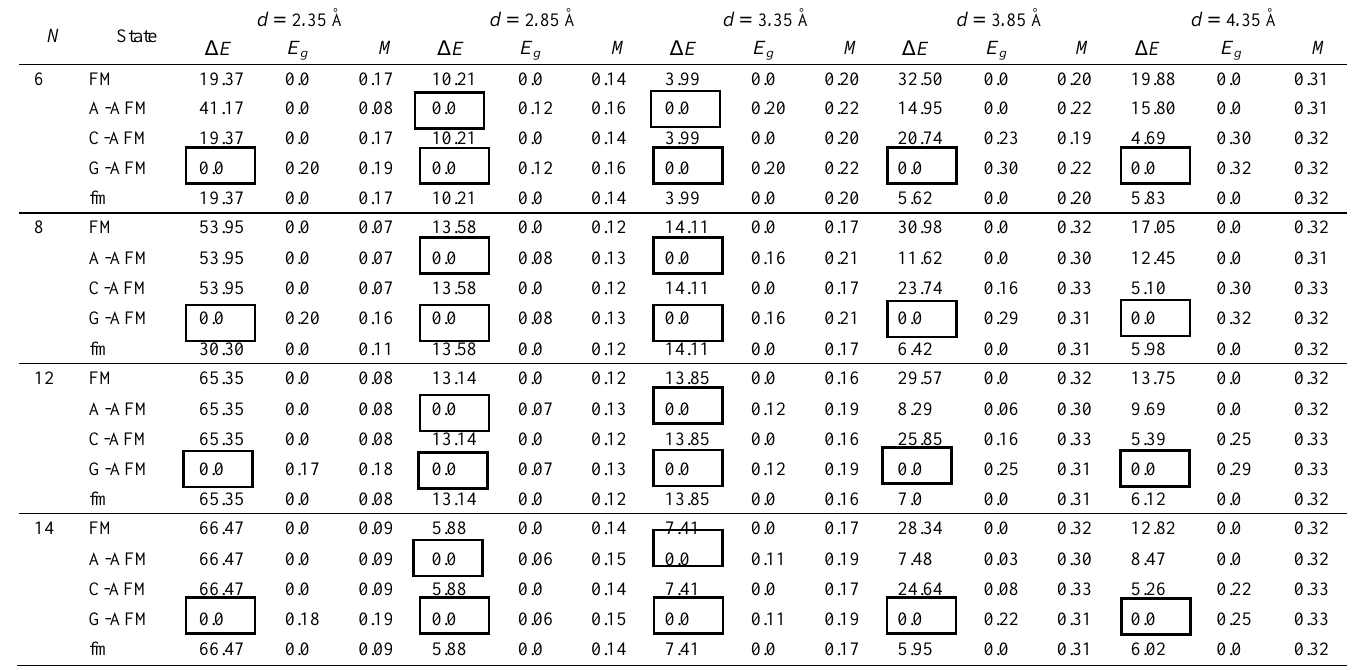
Table 1. Computed total energy difference ∆ E (meV), energy gap E g (eV), and averaged magnetic moment of four edge carbon atoms M (µB/atom) of N - ZGNR under several configurations and thicknesses d . Here, the total energy difference ∆ E is calculated with respect to the ground state. The boxes refer to the ground states